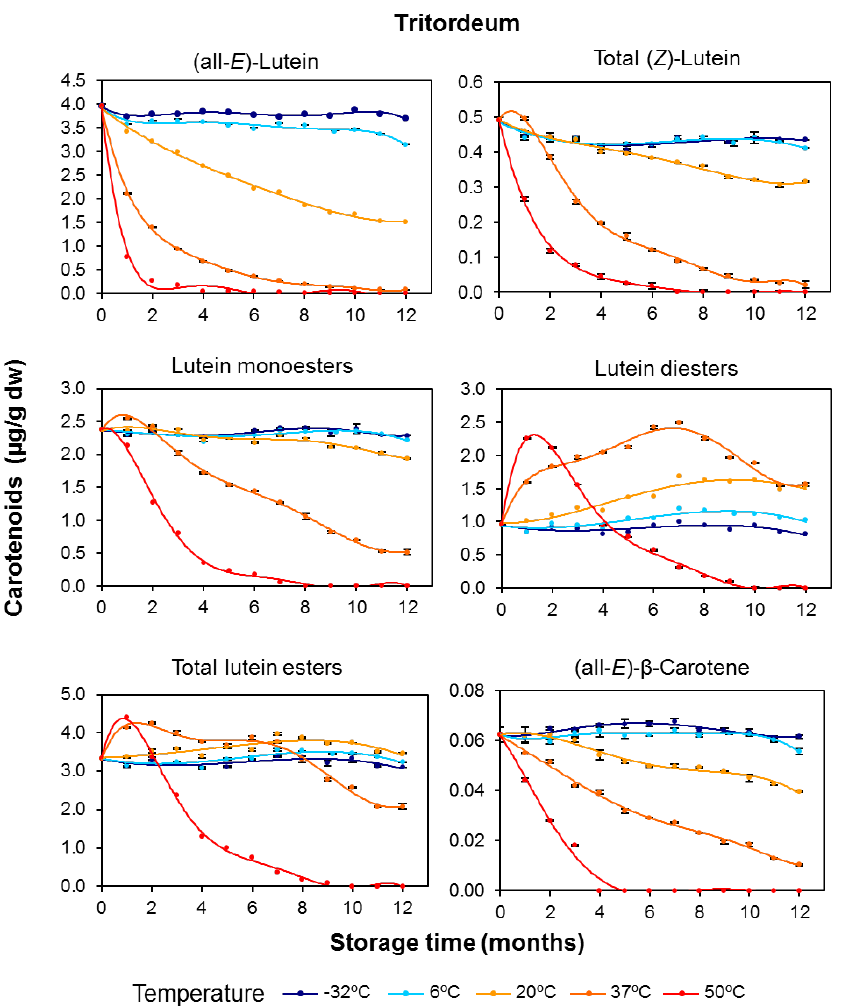
Figure 3. Evolution of the individual carotenoid content and esterified fractions (μg/g dry weight) in tritordeum (HT621 advanced line) whole-grain flours during long-term storage under temperature controlled conditions (−32, 6, 20, 37 and 50 °C). The values shown are the mean and standard error ( n = 5 for the starting sample, n = 3 for the rest of the samples).